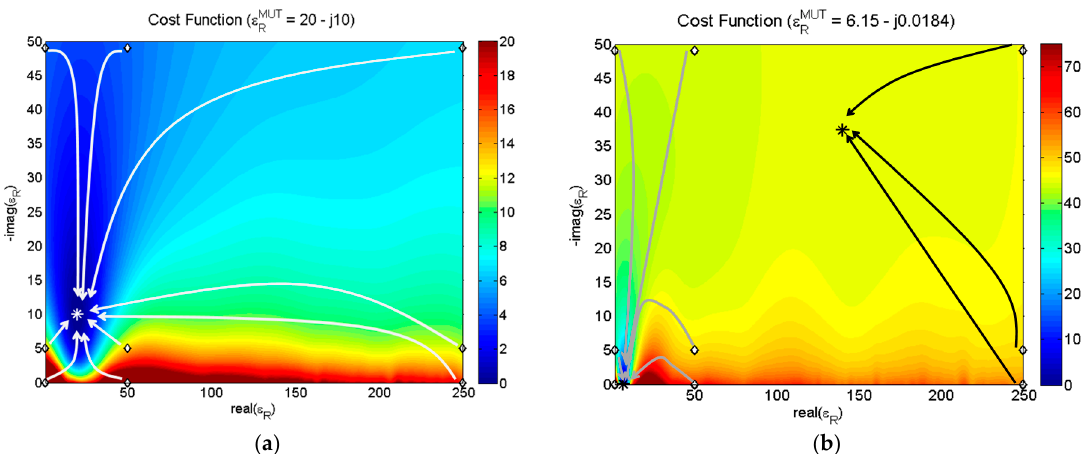
Figure 8. Representation of the convergence of the algorithm on the complex space of the dielectric permittivity. The searched values are ( a ) ε R = 20 − j10 and (b). ε R = 6.15 − j0.0184.